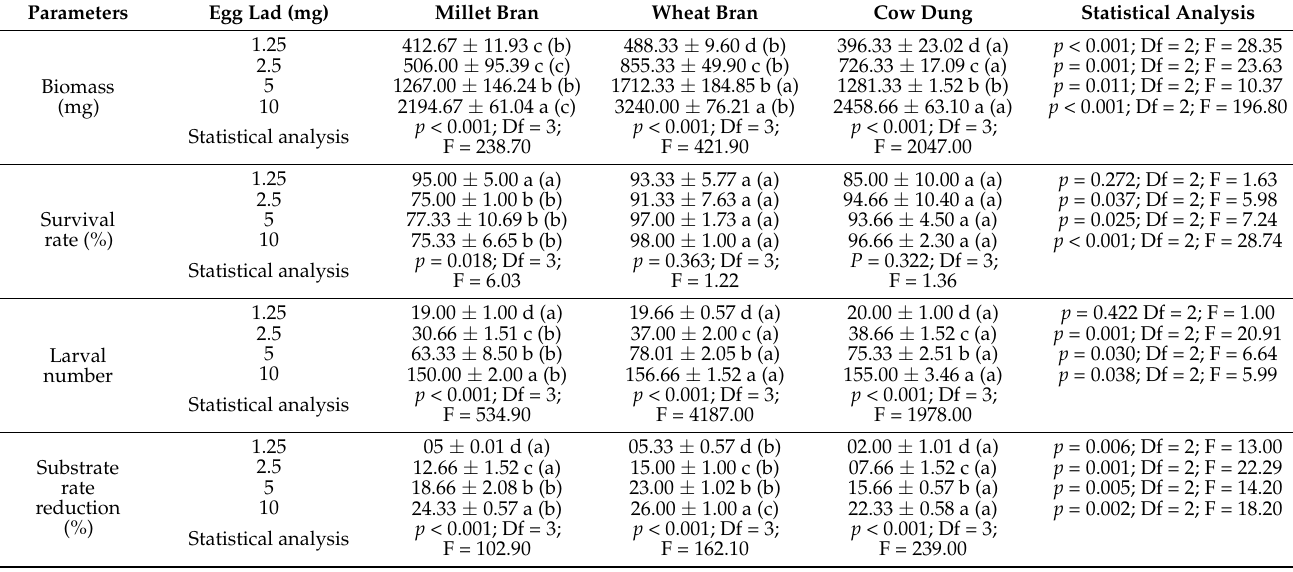
Table 2. ANOVA of biological parameters inside different substrates as a function of egg load and between the different